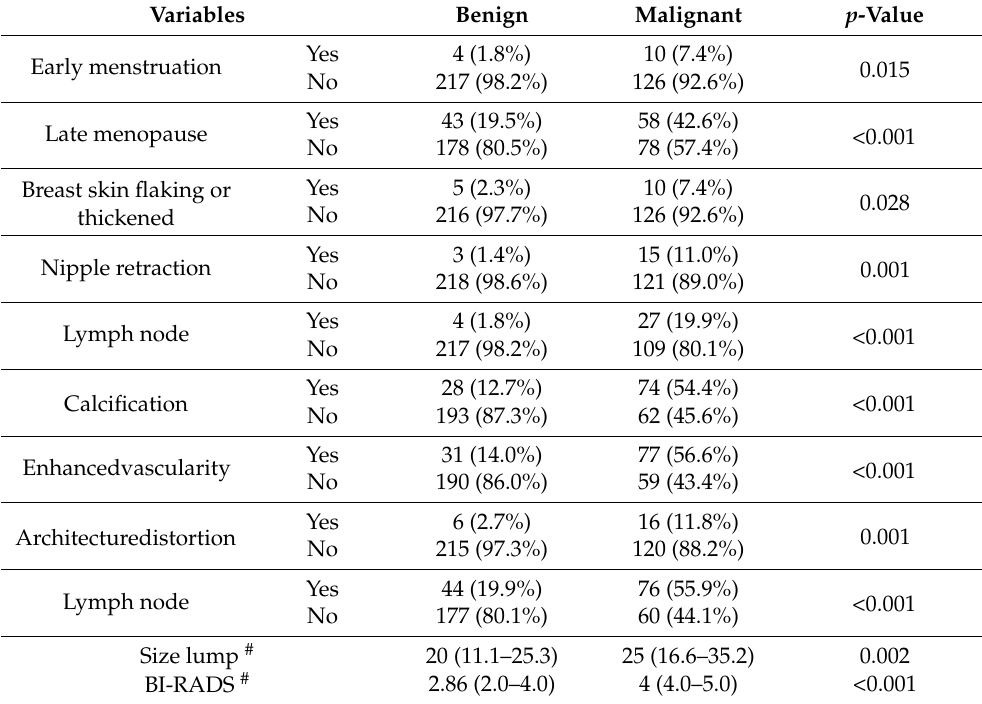
Note: # denotes these continuous variables are expressed with mean and standard deviation.